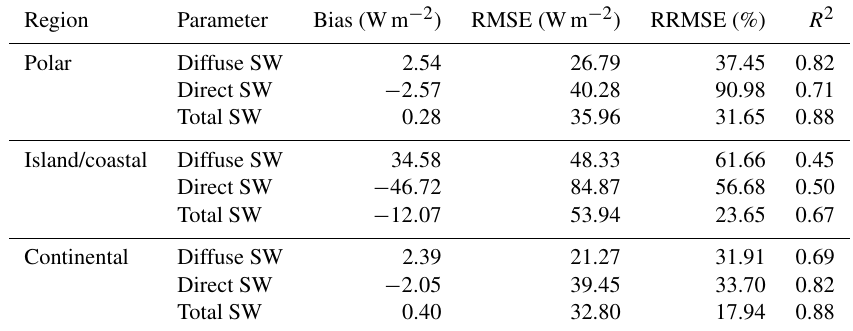
Table 2. Evaluation of EPIC-based daily SW estimates against the ground-based measurements for different regions.